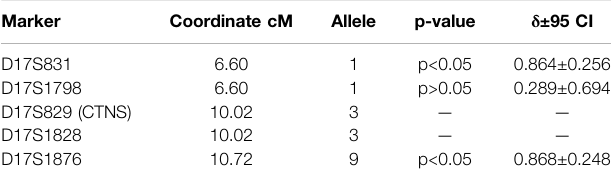
TABLE 4 | Linkage disequilibrium analysis between CTNS c.1015G > A mutation and microsatellites closest to the CTNS gene.